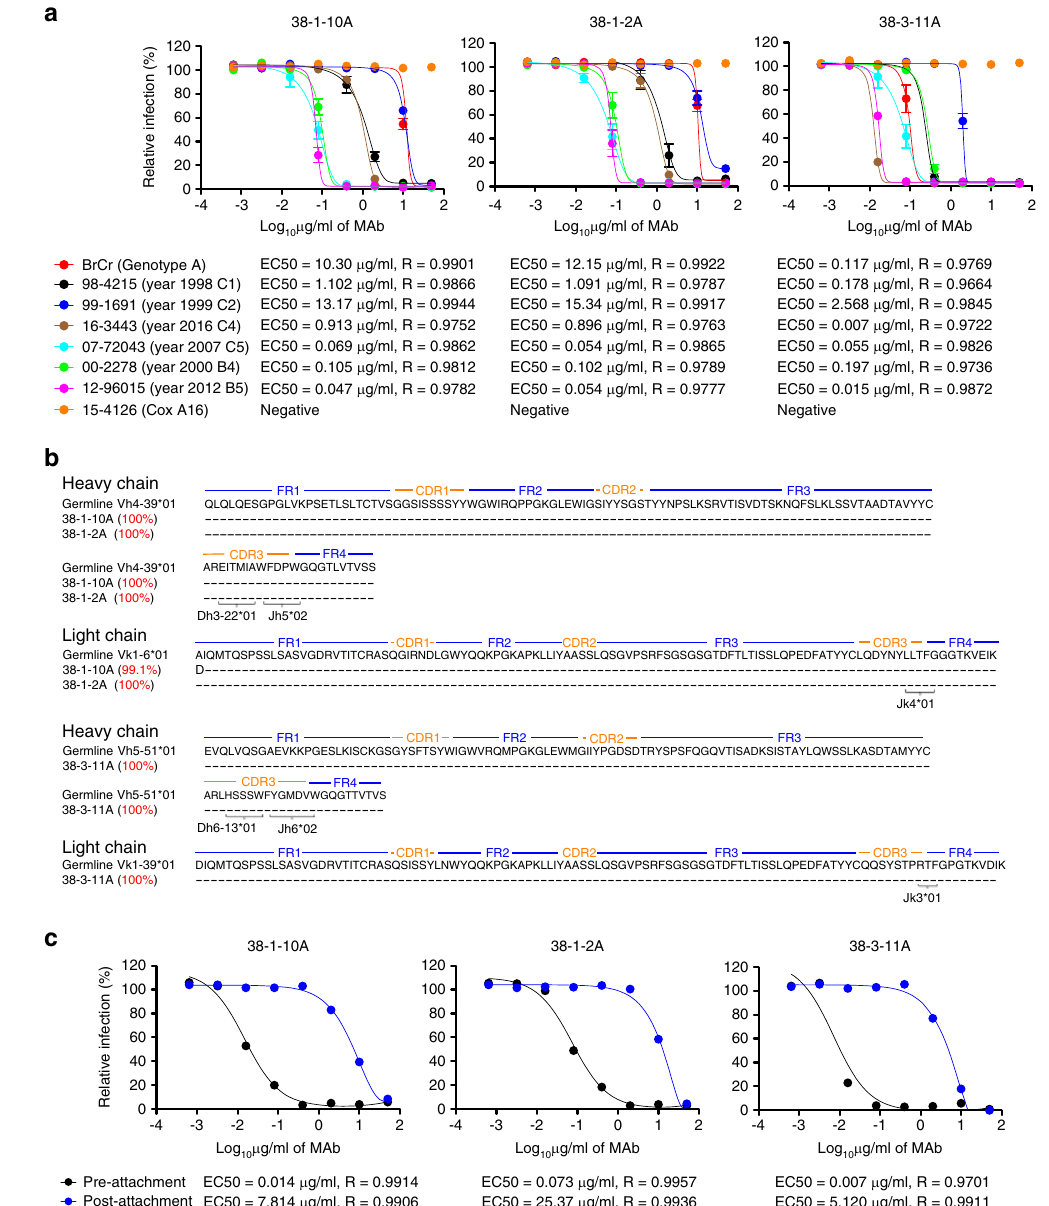
Fig. 2 Characterization of threefold plateau-binding neutralizing antibodies. a Neutralizing activities of antibodies 38-1-10A, 38-1-2A and 38-3-11A against a panel of EV71 clinical strains in 1998 – 2016 and the prototype BrCr strain. The neutralization experiment was conducted three times independently ( n = 3). Data are presented as mean ± standard error of the mean. Error bars represent the standard error of mean. The concentration of antibody that inhibited infection by 50% (EC50) was determined using nonlinear regression (log concentration vs. response, variable slope) in GraphPad Prism. A Coxsackievirus A16 was included in the neutralization assay as the control. b Immunogenetic analysis of the heavy and light chain variable regions of neutralizing antibodies using the IMGT tool. c Inhibition of EV71 12-96015 infectivity at pre- and post-attachment stages by neutralizing antibodies. Data are presented as the mean for measurements from two independent experiments ( n = 2). The concentration of antibody that inhibited infection by 50% (EC50) was determined using nonlinear regression (log concentration vs. response, variable slope) in GraphPad Prism. Source data are provided as a Source Data fi